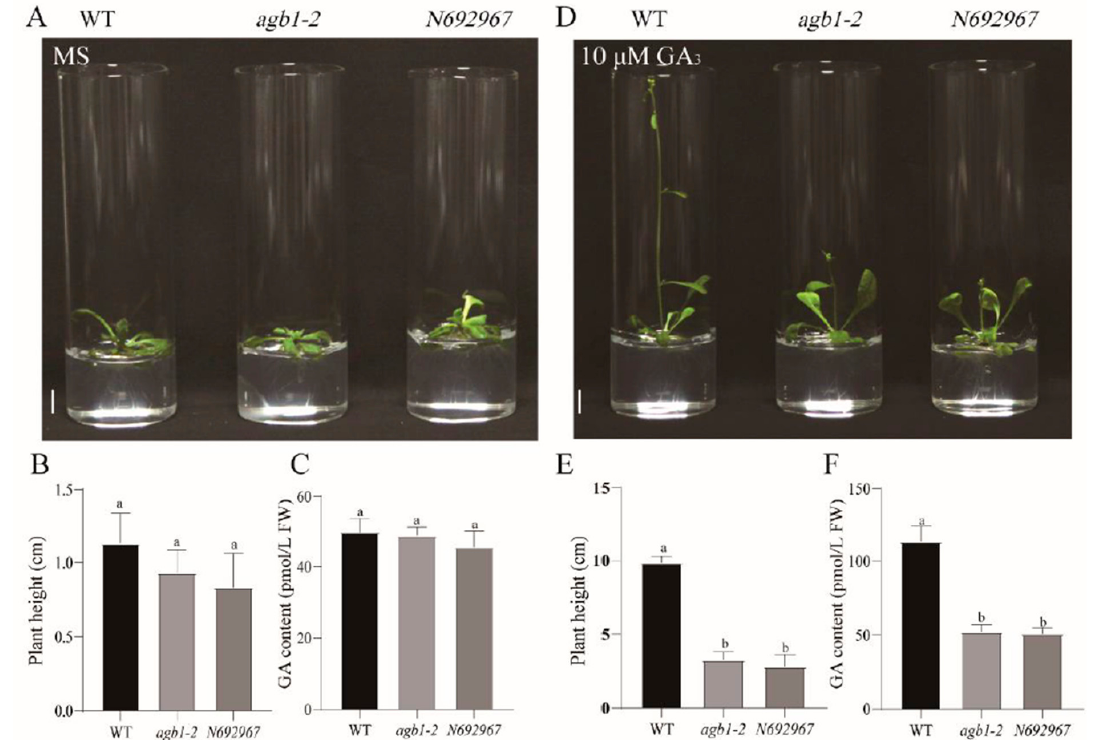
Figure 1. Phenotypes of the wild-type (Col-0), agb1-2 , and N692967 under GA 3 treatment. ( A ) Plant height phenotypes of the wild-type (Col-0), agb1-2 , and N692967 under normal conditions. Scale bars, 1 cm. ( B , C ) Plant height and GA content of the wild-type (Col-0), agb1-2 , and N692967 under normal conditions. Data are the average of three independent experiments, and the error bars represent SE ( n = 10). Significant differences were analyzed using Duncan’s multiple range test ( p < 0.05). ( D ) Plant height phenotypes of the wild-type (Col-0), agb1-2 , and N692967 treated with 10 µ M GA 3 . Scale bars, 1 cm. ( E , F ) Plant height and GA content of the wild-type (Col-0), agb1-2 , and N692967 under normal conditions. Data are the average of three independent experiments, and the error bar represents the SE ( n = 10). Significant differences were analyzed using Duncan’s multiple range test ( p < 0.05).